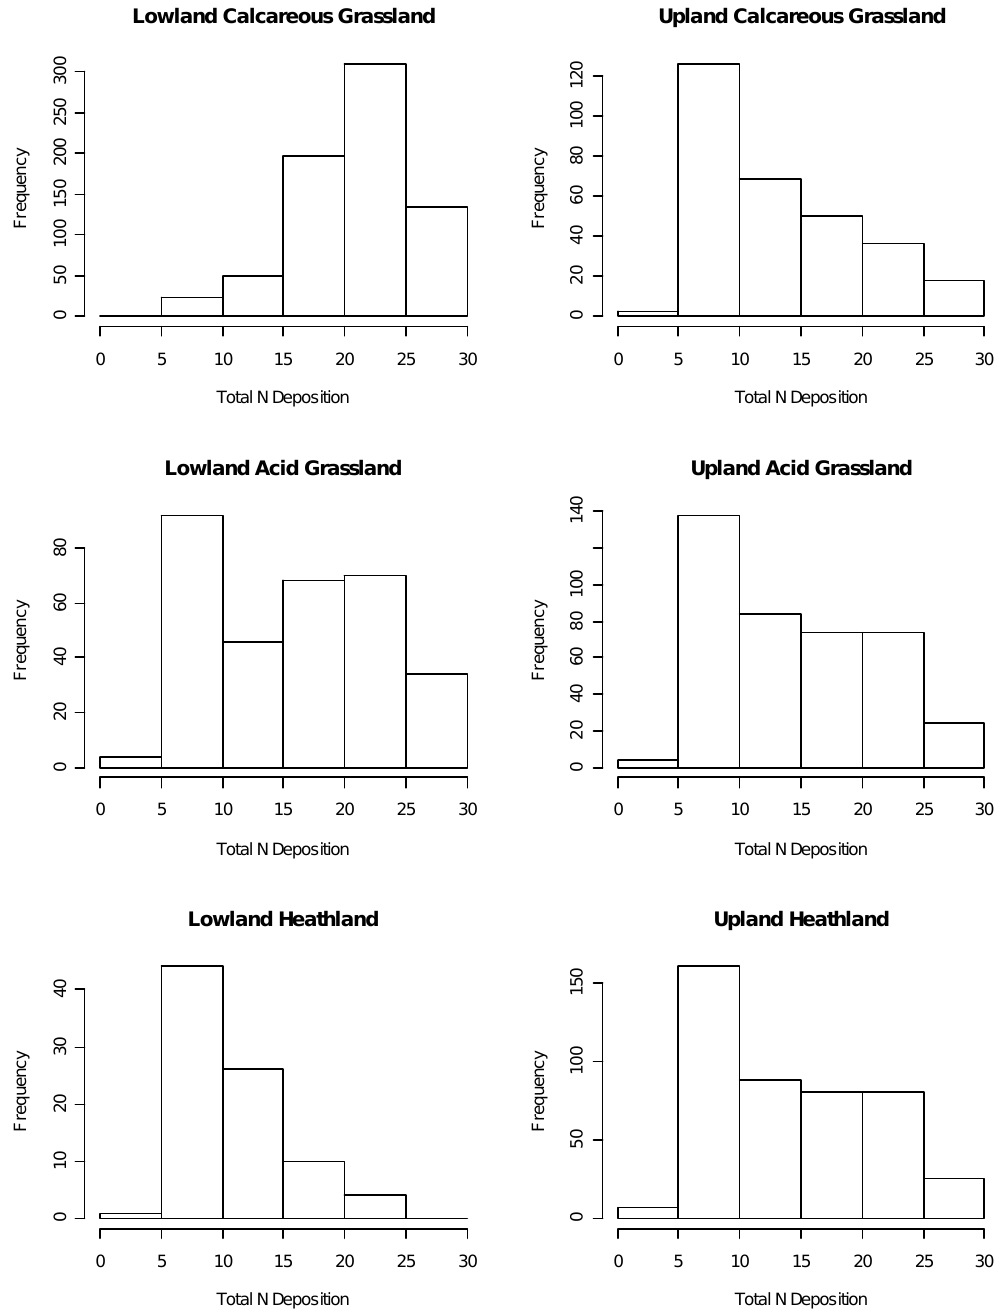
Fig. A2. Histograms showing the distribution of N deposition in the BSBI local change survey data between 0–30kgNha − 1 yr − 1